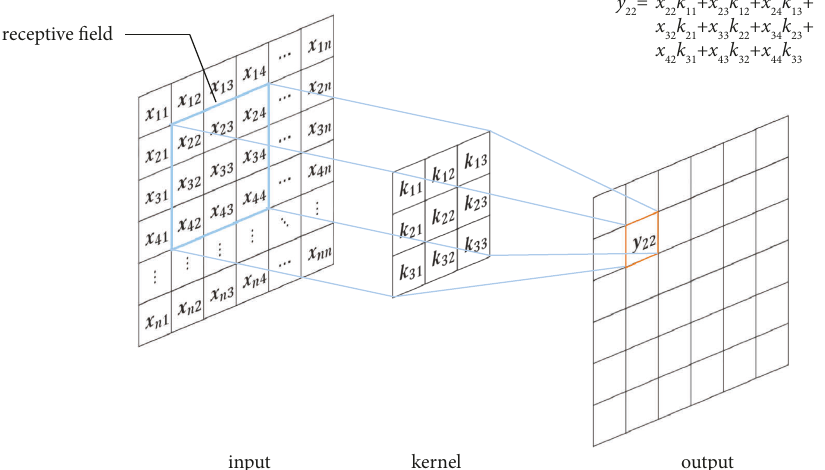
Figure 2: Schematic diagram of convolution operation.